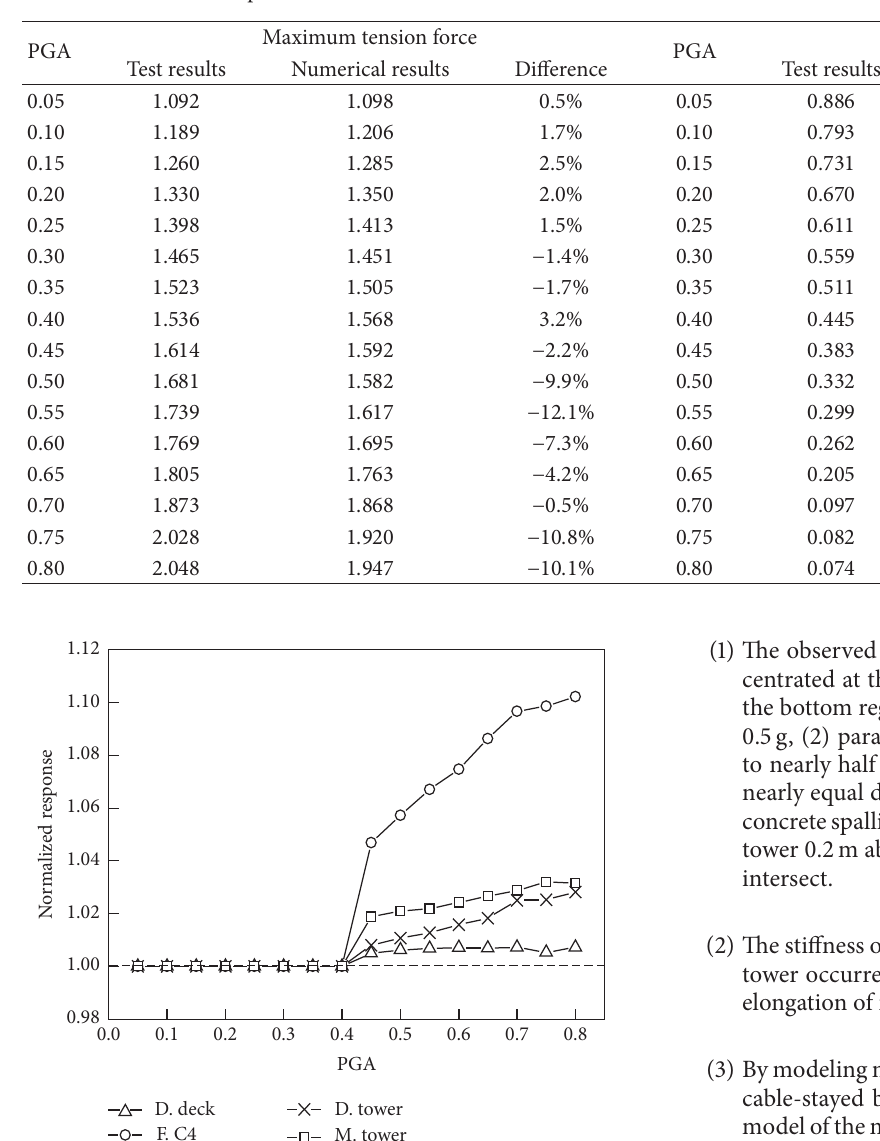
Table 8: Comparisons of normalized maximum and minimum cable forces between measured and numerical results.